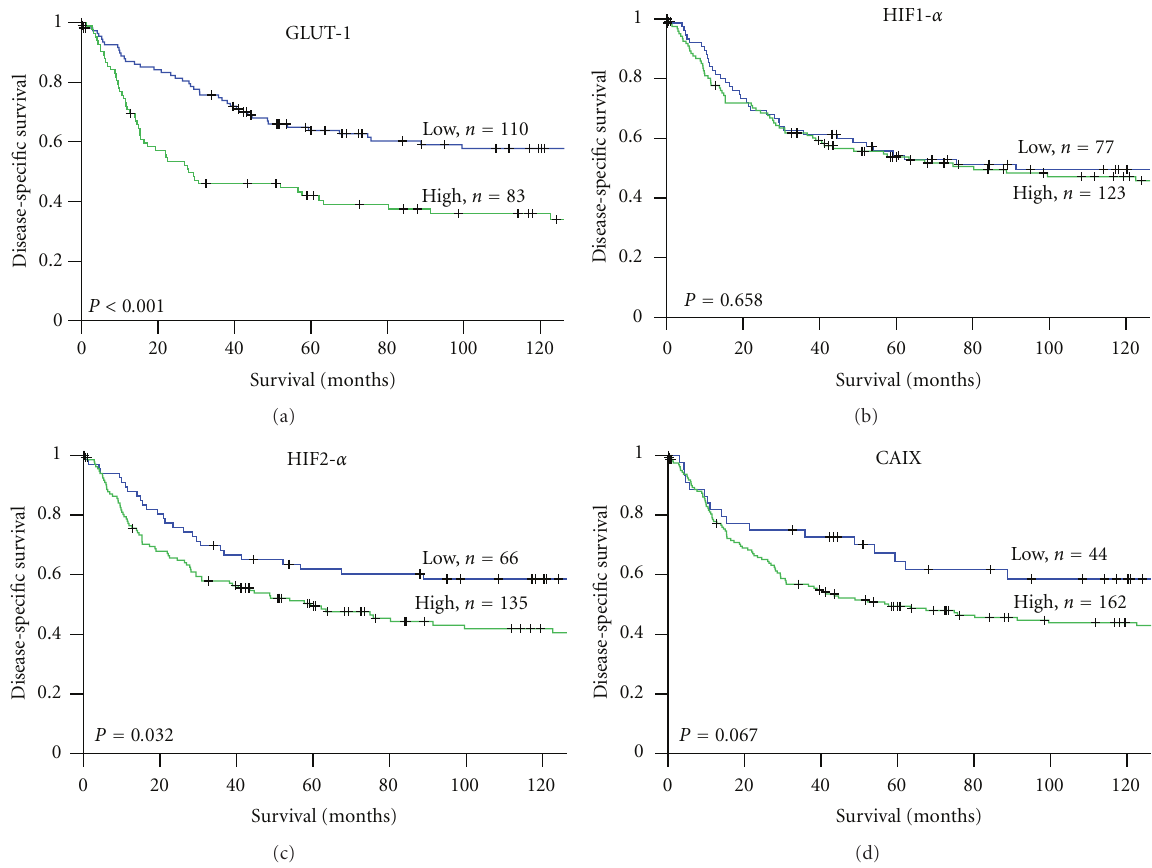
Figure 2: DSS curves according to GLUT-1 (a), HIF-1 α (b), HIF-2 α (c) and CAIX (d) expression in non-GIST STS. DSS: disease-specific survival, GLUT-1: glucose transporter-1, HIF-1/2 α : hypoxia induced factor 1/2 α , CAIX: carbonic anhydrase IX, and non-GIST STS: non- gastrointestinal stromal tumor soft tissue